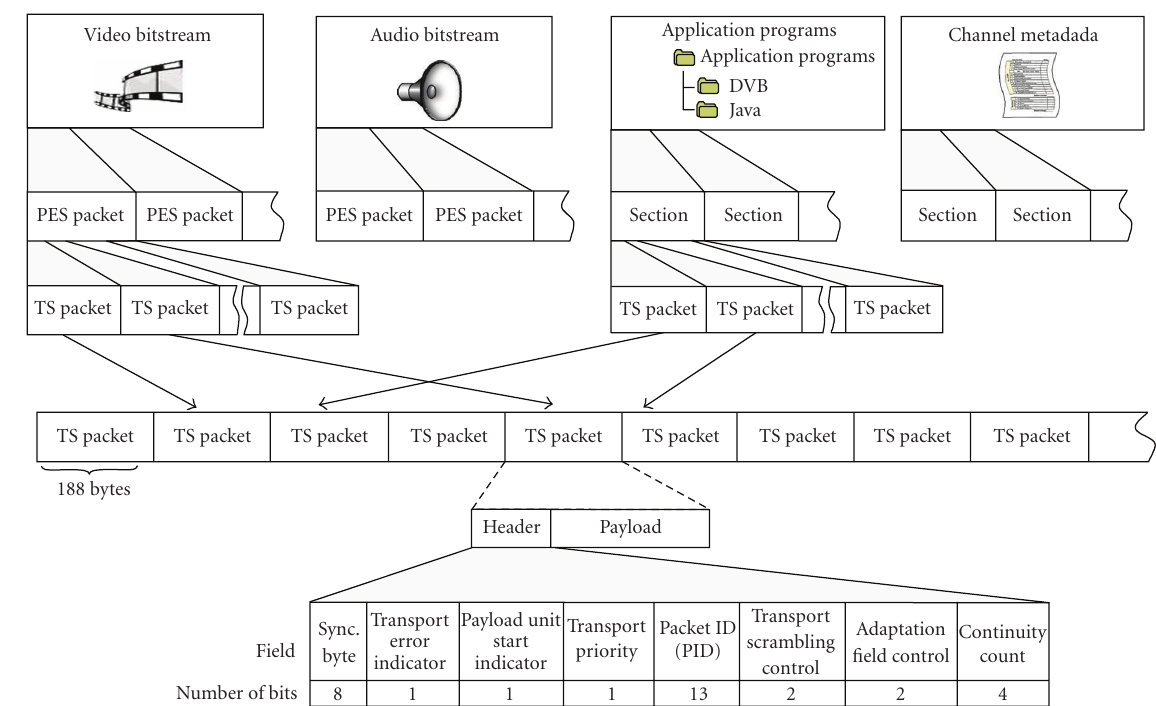
Figure 1: Detailed structure of the MPEG-2 transport stream (TS).